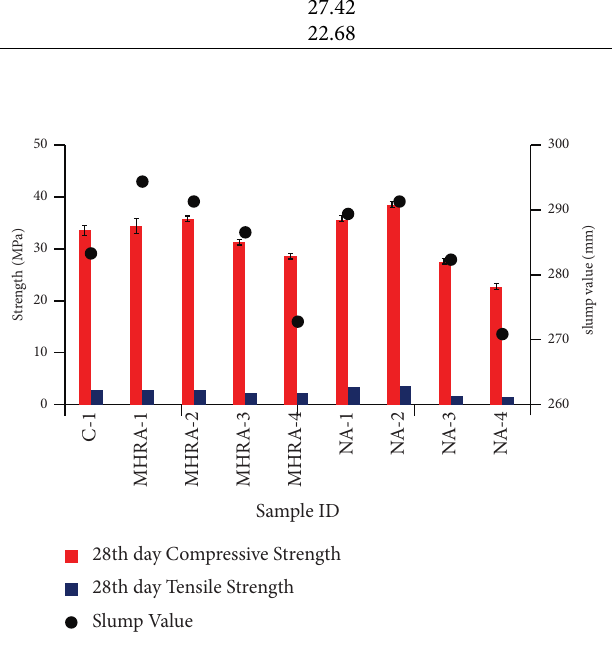
Figure 7: Ultimate strength and